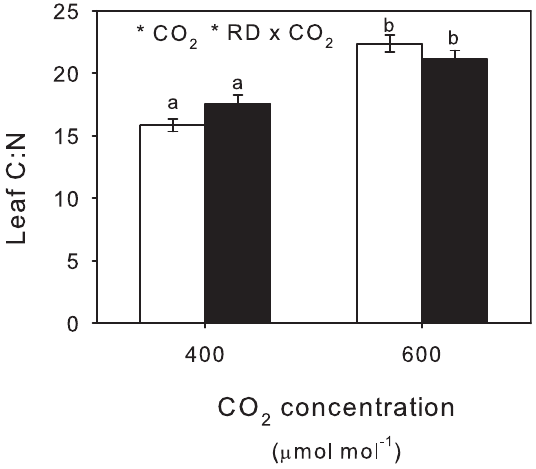
Figure 4. Leaf C:N ratios. Effects of aCO 2 and eCO 2 on leaf C:N from plants without (open bars)and with root damage (RD). Mean values 6 S.E. shown, N=24. Statistical significance of treatments indicated *( P , 0.05) with lowercase superscript letters indicating significant differences ( P , 0.05) between treatments.